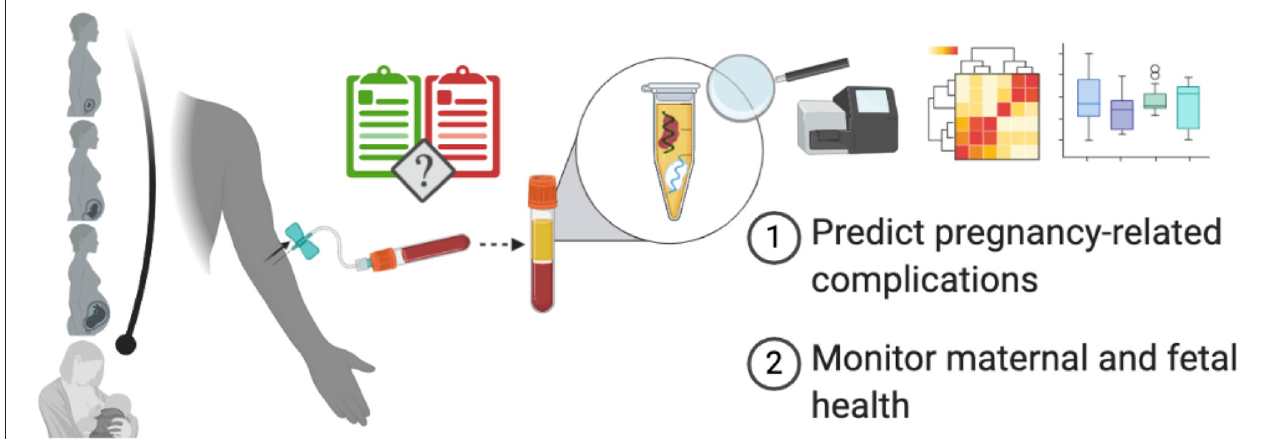
FIGURE 1 | Using cfRNA to monitor pregnancy and predict pregnancy-related complications. From conception until delivery, cfRNA isolated from maternal plasma can provide a snapshot of fetal and maternal health and may even predict pregnancy-related complications prior to their clinical onset, thereby helping guide clinical practice. Created with